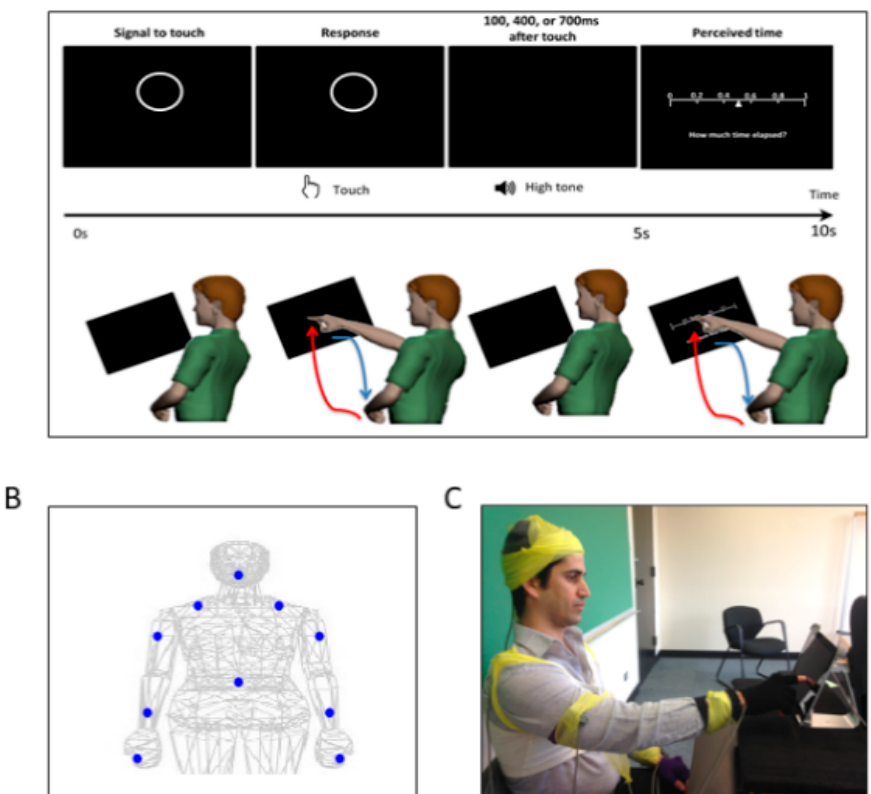
Figure 2. Experimental assay and instrumentation setup. ( A ) Experimental procedure. In a single trial, the participant was presented with a display screen, as shown on the top panel. During the first 5 s, the participant was presented with a circle as a prompt to touch the circle on the screen. After the touch, the participant heard a tone. The duration between the touch and the tone was randomly set to be 100 ms, 400 ms, or 700 ms. In the next 5 s, the participant was presented with a sliding scale, where s / he indicated how long the time was perceived to have elapsed between the touch and the tone, by touching the corresponding number on the scale. For each trial, the participant made two pointing gestures—one to touch the circle and another to indicate their time estimation on the sliding scale. Such pointing gesture was composed of a forward reaching segment (red) and a backward retracting segment (blue), as shown in the bottom panel. ( B ) Motion capture sensor positions. The sensors were attached on the following body parts: center of the forehead, thoracic vertebrate T7, right and left scapula, right and left upper arm, right and left forearm, non-performing hand, and the performing hand’s index finger. ( C ) Snapshot of the experiment. During the experiment, the participant was seated in front of the tablet screen to perform the tasks, and wired sensors were secured with athletic tape.